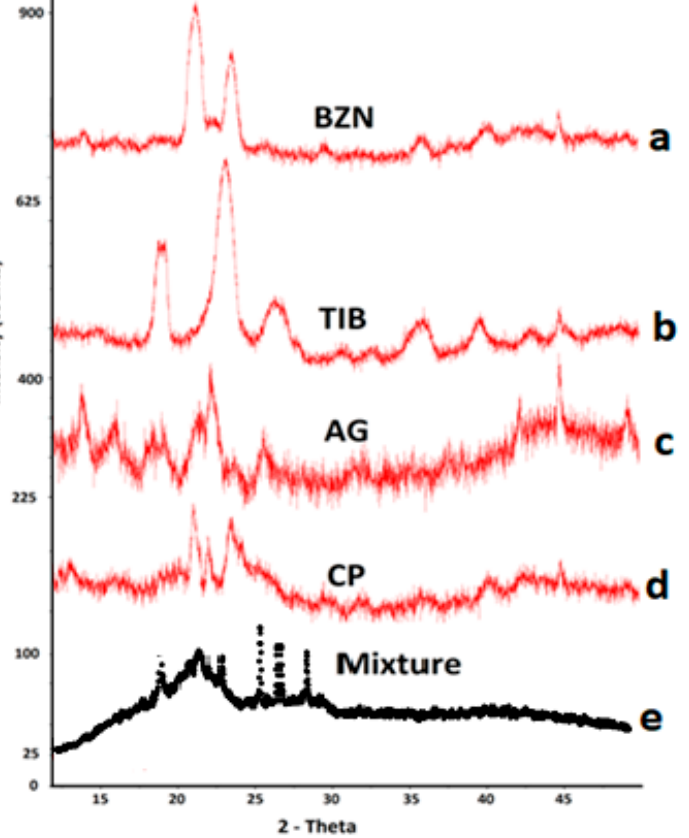
Figure 6. XRD spectra of ( a ) BZN, ( b ) TIB, ( c ) CP, ( d ) AG and ( e ) the physical mixture of polymers with BZN and TIB.